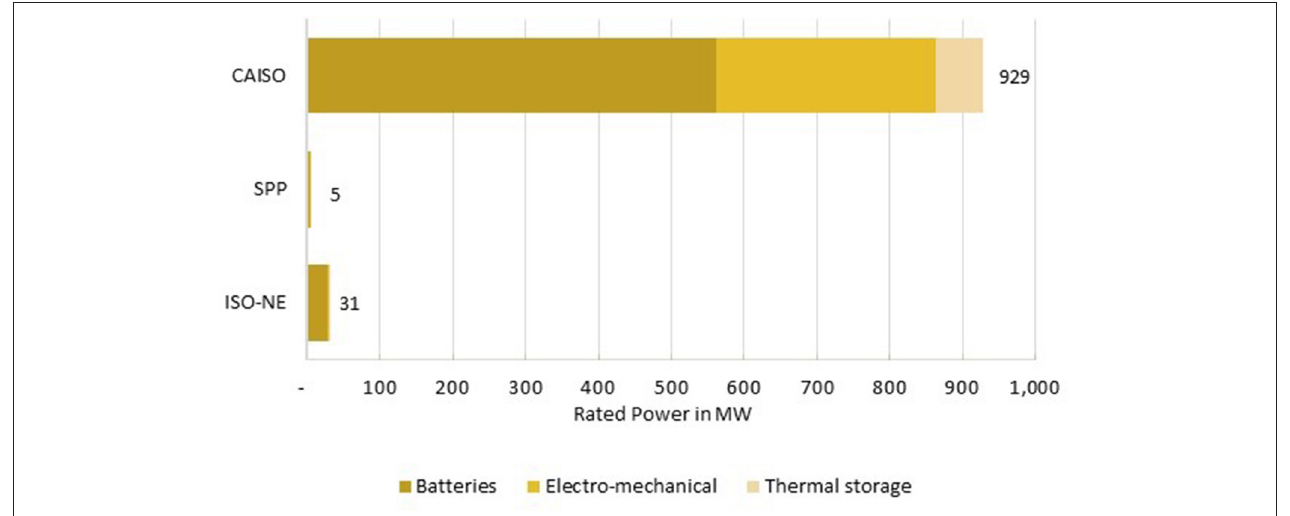
FIGURE 3 | Rated power of energy storage projects by regional transmission organizations in 2020 (MW)*. *Excludes pumped-storage hydroelectric projects. Sources: National Technology & Engineering Sciences of Sandia, LLC, 2020.